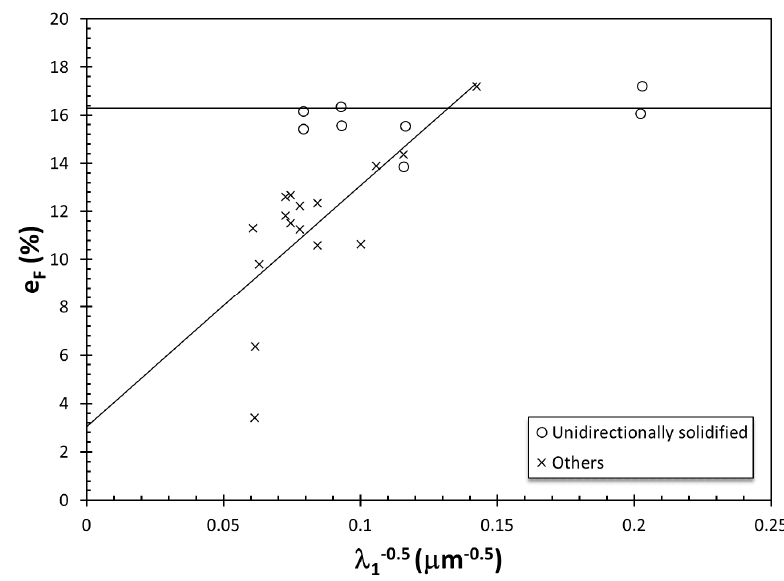
Figure 4. The change in elongation with the inverse square root of primary dendrite arm spacing in steel castings (data from [74]).